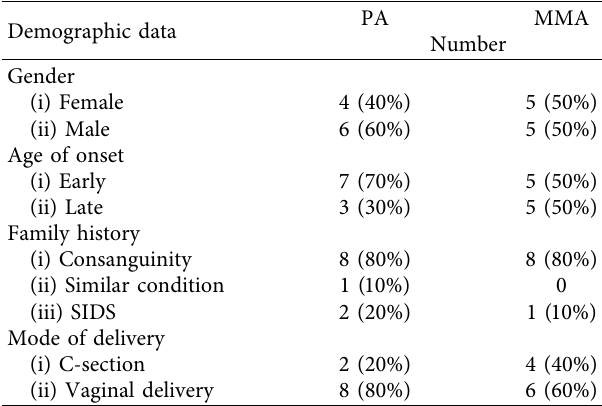
Table 2: Comparison between the demographic data of both PA and MMA